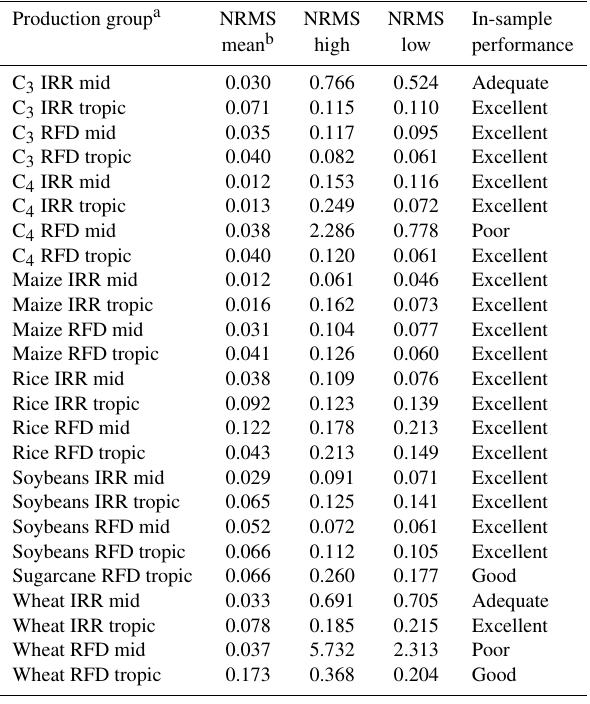
Table A7. Persephone v1.0 response function performance for all production groups, for pure µ CTW (Eq. A4), quadratic σ CTW (Eq. A6).